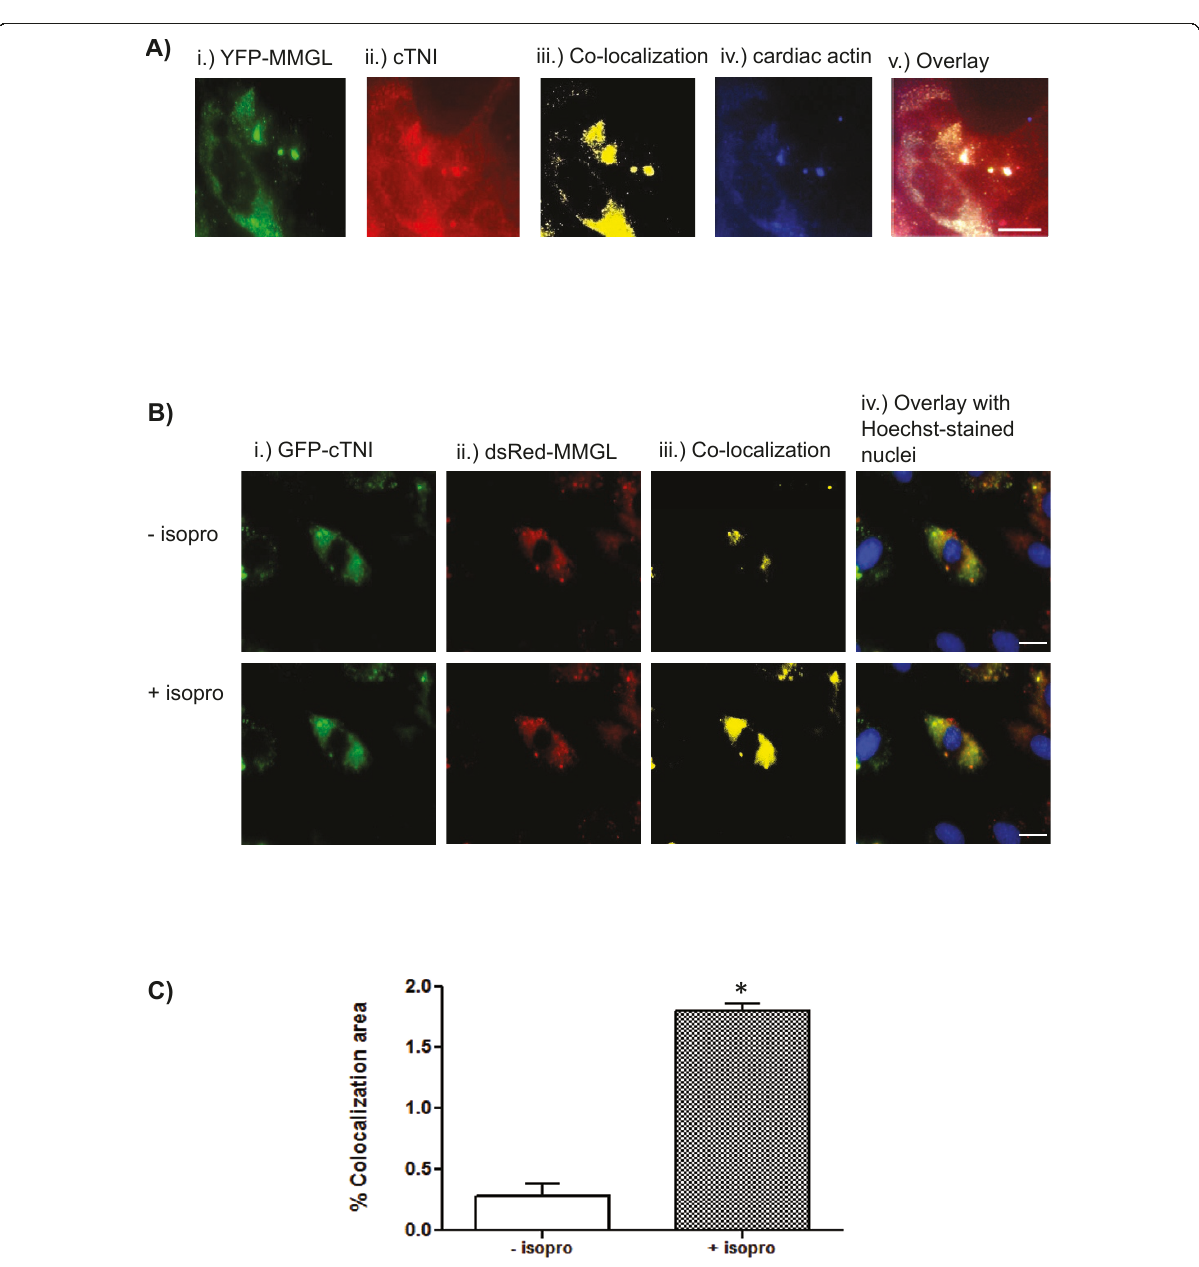
Figure 5 Co-localization increases between MMGL and PKA target upon b -adrenergic stimulation . A . Representative image of live cell fluorescence microscopy showing co-localization of cTNI and MMGL isoform 4. Each panel represents a single frame of the 25 images that were captured for the vertical Z-stack. The first four panels show a single colour channel, while the image in the last panel shows an overlay of the four colour channels used. Column (iii) shows co-localization (yellow fluorescence) between dsRed-cTNI and YFP-MMGL, while column (iv) shows cardiac actin, a marker of the sarcomeric region. Scale bar: 0.02 mm. B . Representative image of live cell fluorescence microscopy showing that co-localization of MMGL isoform 4 and cTNI increases under adrenergic stress. Each panel represents a single frame of the 25 images that were captured for the vertical Z-stack. Each of the first three columns shows a single colour channel, while the image in the last column shows an overlay of the four colour channels used. Column iii shows co-localization (yellow fluorescence) between dsRed-MMGL and GFP-cTNI in the absence (-isopro) and presence (+isopro) of the beta-adrenergic agonist, isoproterenol. The increase in intensity of yellow fluorescence in the second row demonstrates that co-localization levels of MMGL and cTNI had increased ten minutes after the addition of isoproterenol. Scale bar: 0.02 mm. C . Quantification of co-localization shown in B shows that co-localization increased significantly (± SEM, * p < 0.05, n = 6) after the addition of isoproterenol. Change in co-localization was calculated using the CellR software and presented as a false colour image and percent co-localization as described by Loos et al ., 2008 [29]. Abbreviations: isopro =